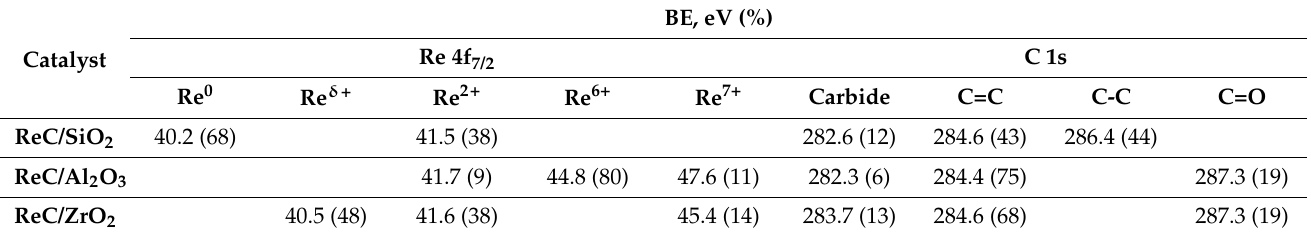
Table 2. XPS data obtained for the catalysts after in situ re-reduction at 350 ◦